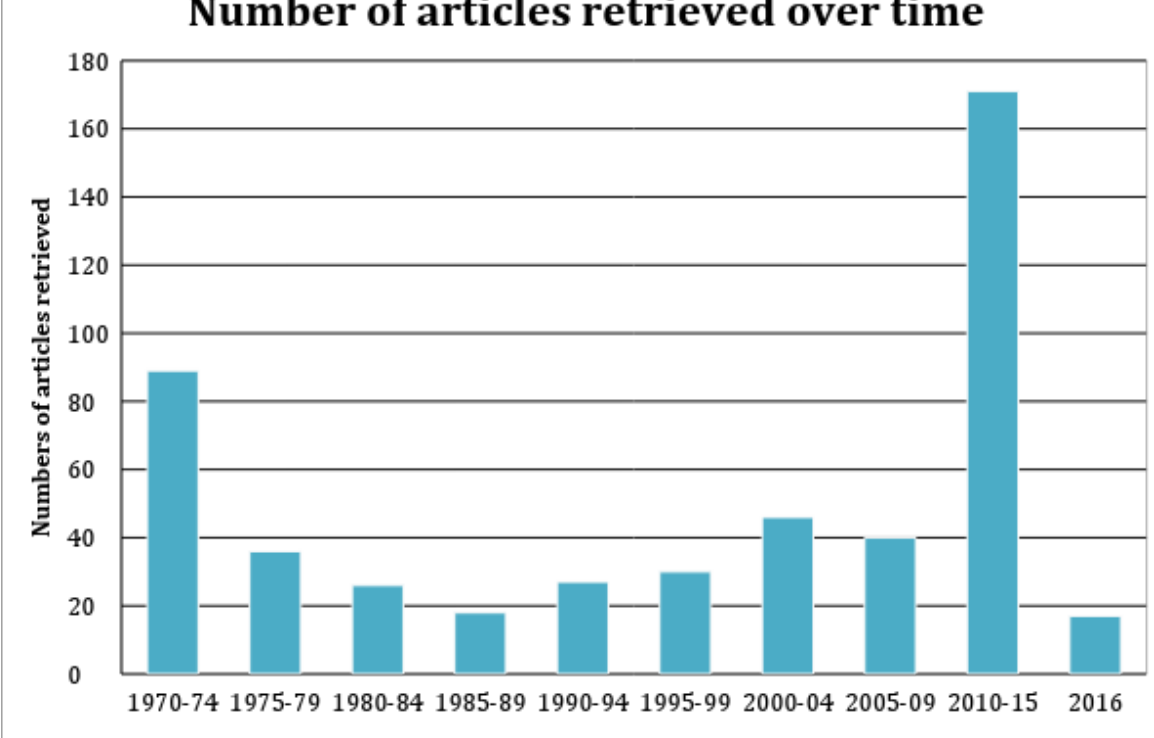
Figure 1: Frequency of published articles on open education over